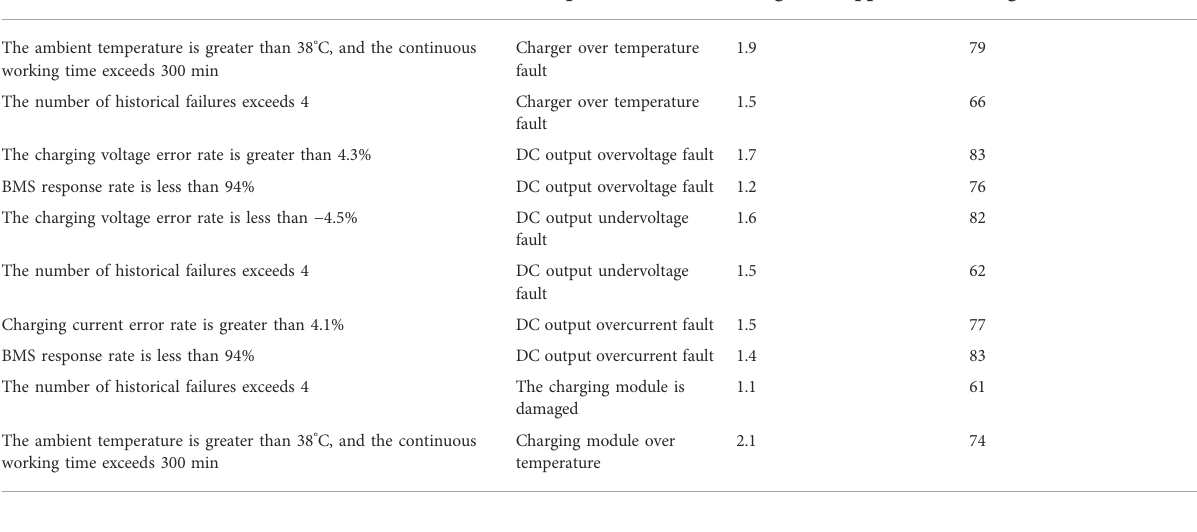
TABLE 9 Correlation level of DC charger failure